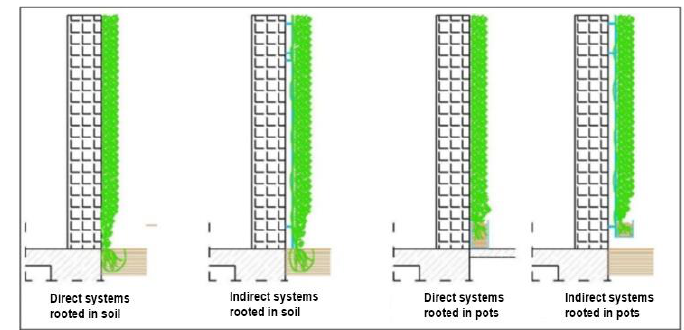
Figure 1 Green facade types (Mir,